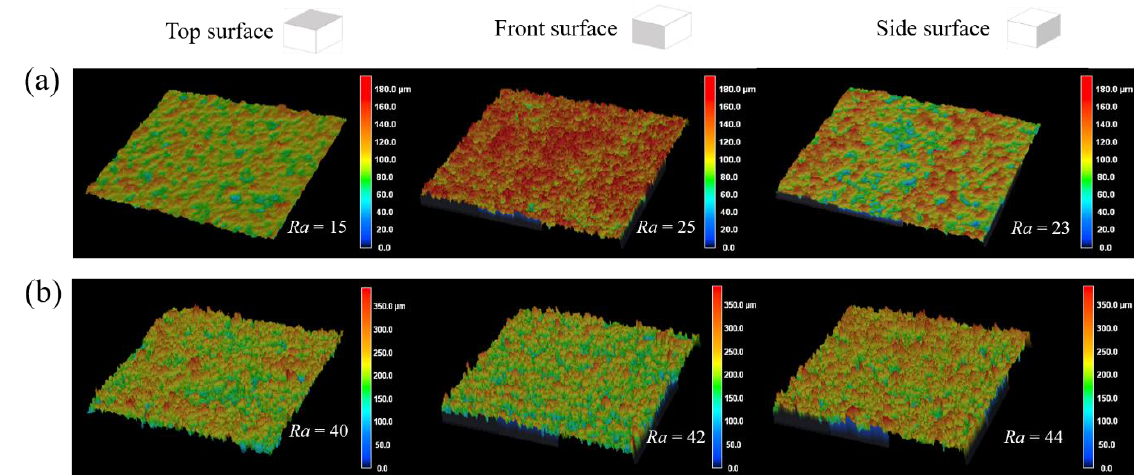
Figure 12. Surface roughness profiles of specimens: ( a ) PA11 and ( b )